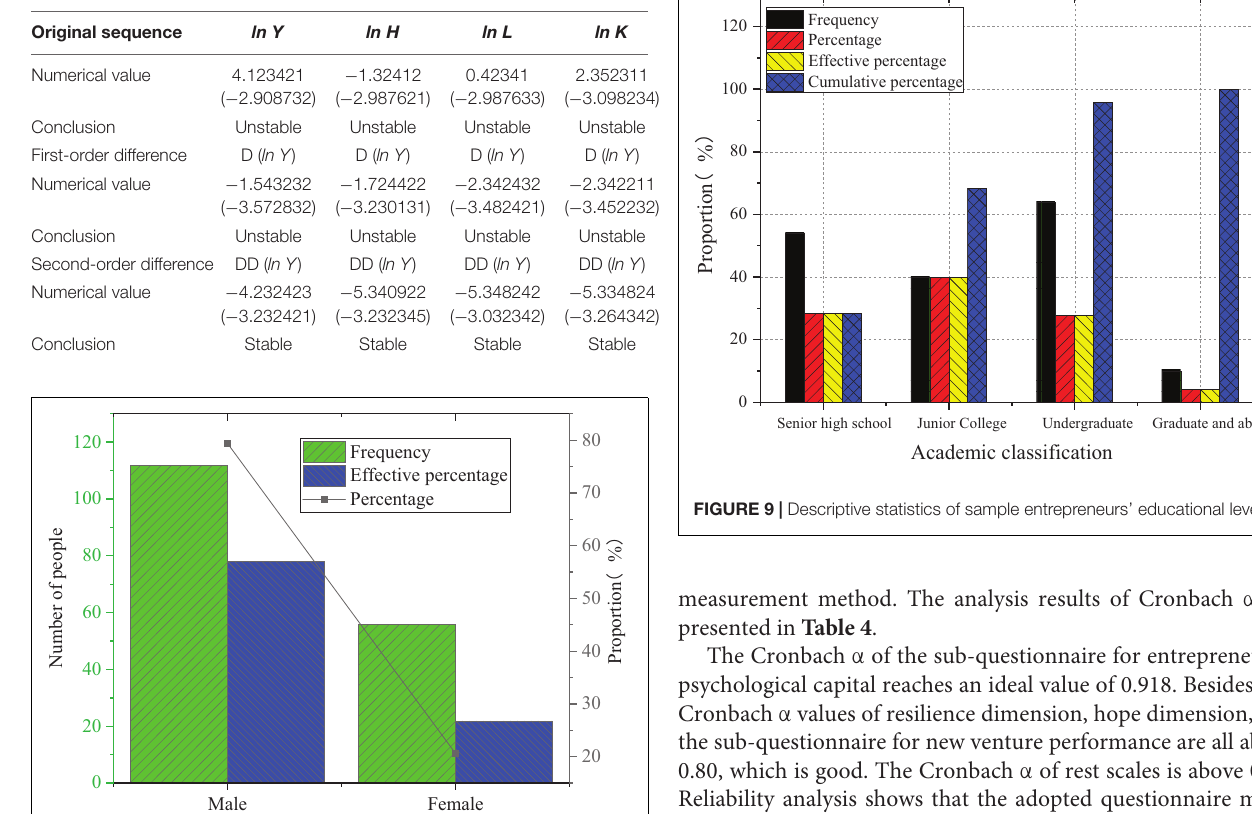
TABLE 3 | Unit root test of variables.